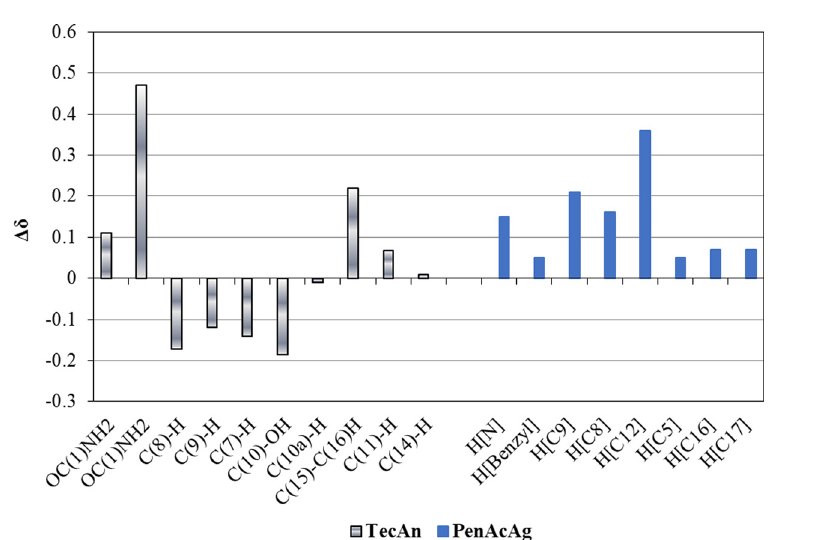
Figure 3: The Δ δ values in 1 H - NMR of TecAn and PenAcAg with respect to the corresponding ones in TecH2 and PenNa in DMSO - d 6